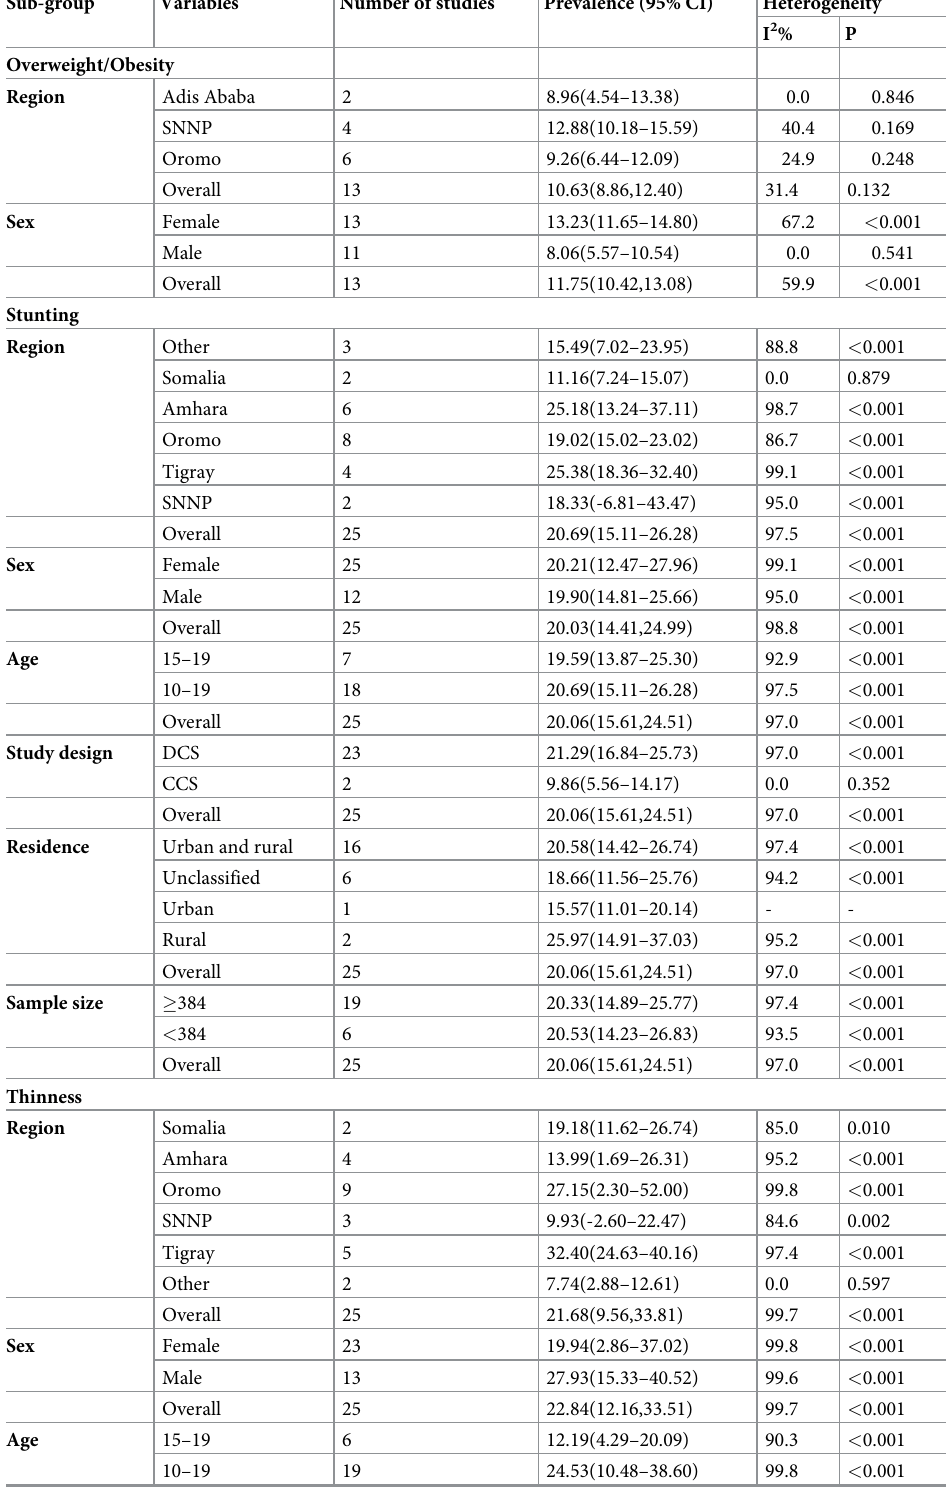
Table 4. Subgroup analysis of double burden of malnutrition among adolescent in